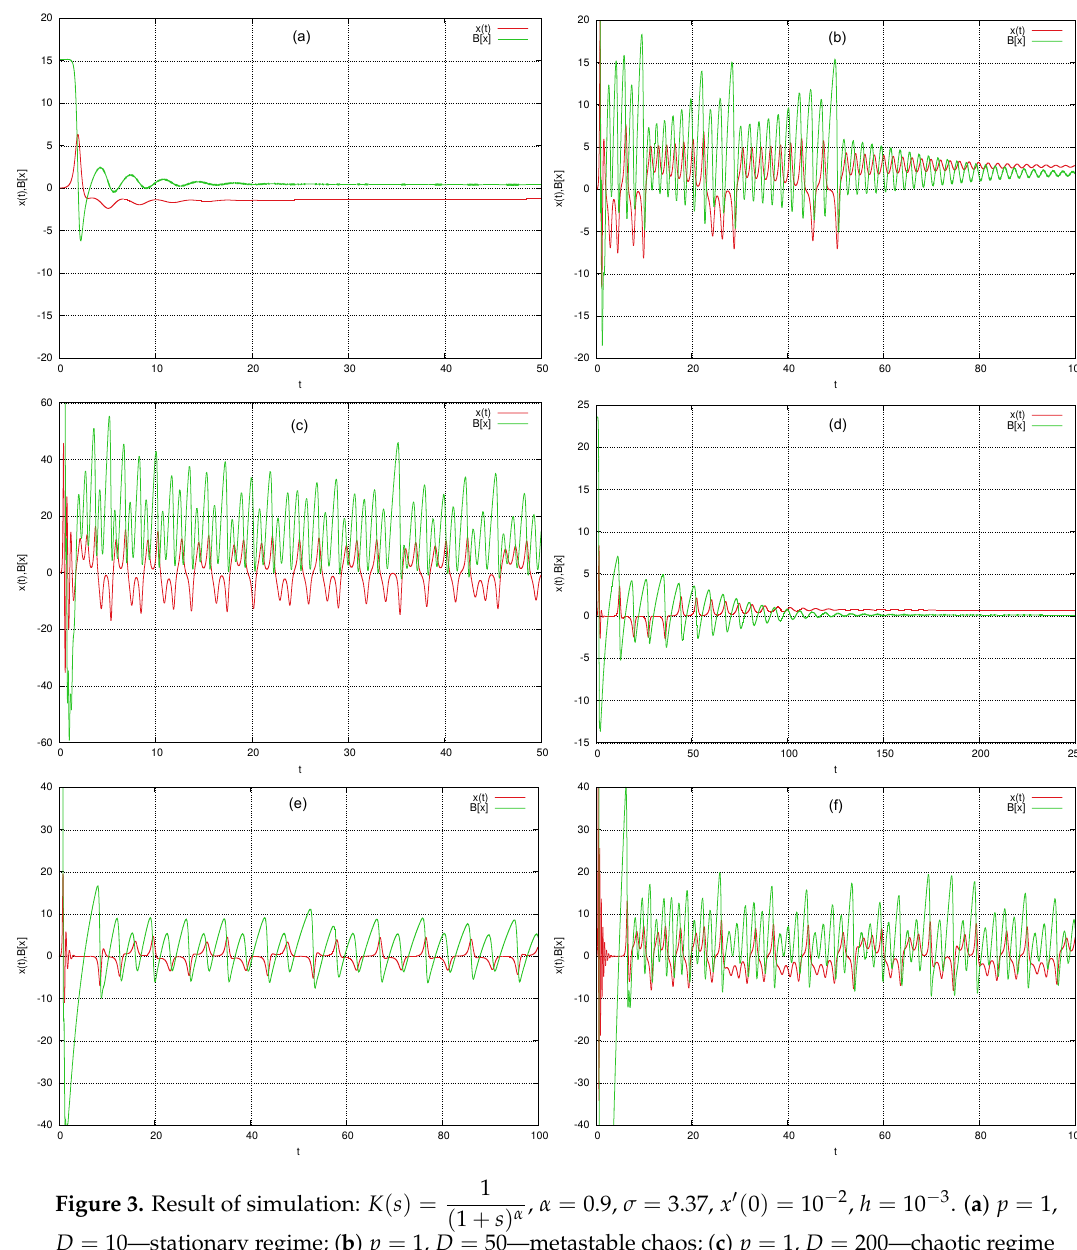
1 Figure 3. Result of simulation: K ( s ) = , α = 0.9, σ = 3.37, x (cid:48) ( 0 ) = 10 − 2 , h = 10 − 3 . ( a ) p = 1, ( 1 + s ) α D = 10—stationary regime; ( b ) p = 1, D = 50—metastable chaos; ( c ) p = 1, D = 200—chaotic regime (reversals and vacillations); ( d ) p = 5, D = 15—damped bursts regime, ( e ) p = 5, D = 50—bursts regime ; ( f ) p = 5, D = 200—chaotic regime (reversals and